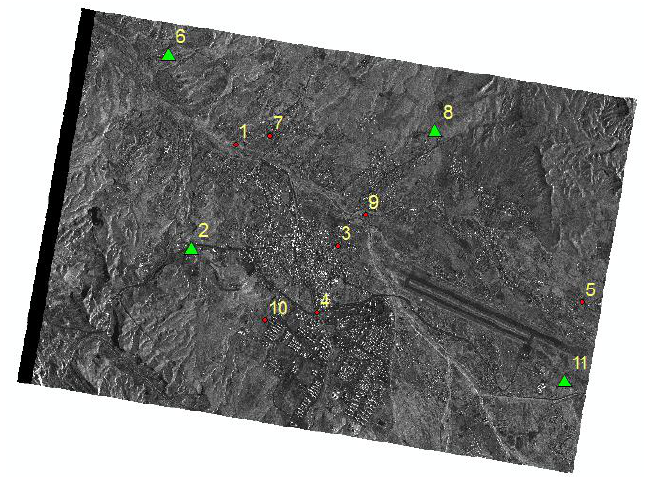
Figure 2. Distributions of ground control points (GCPs) and check points (CKPs) in the study area for a scenario involving five GCPs. Note: triangles represent the GCPs, and circles represent the CKPs.